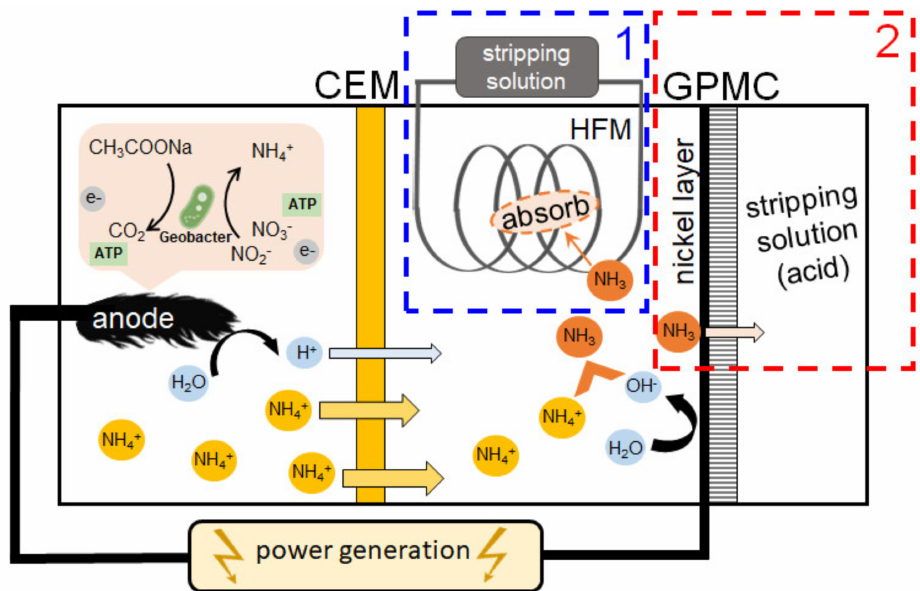
Figure 5. Schematic diagram of an MMFC for energy production and NH 3 volatilization, which contains cation-exchange membrane (CEM) and hollow fiber gas separation membrane (HFM) (1) or flat gas-permeable membrane cathode (GPMC) (2). Adapted and modified from